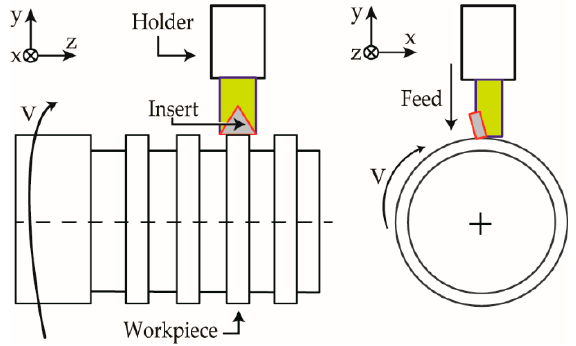
Figure 2. Schematic of orthogonal cutting process. Table 1. Cutting parameters.